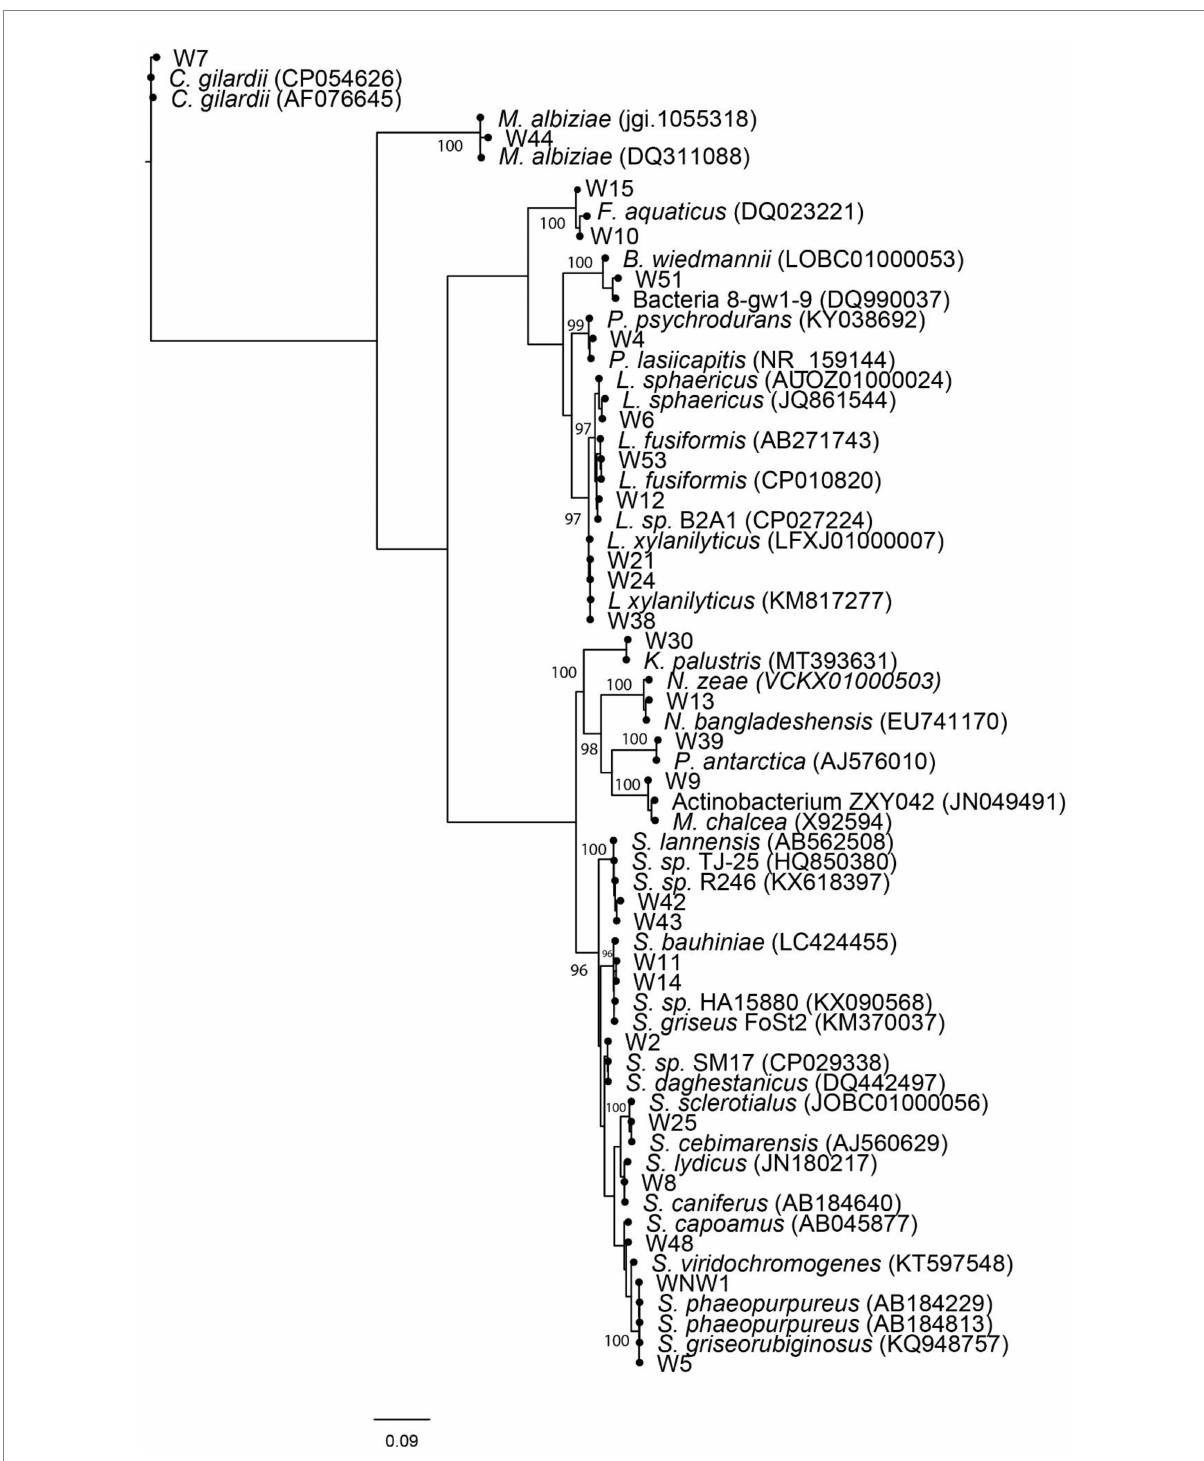
FIGURE 4 Weighted maximum likelihood tree, arbitrarily rooted on the branch leading to Proteobacteria. Non-parametric bootstrap values >95% have been indicated. Culture (NW1, W2–W54) isolates together with EzBioCloud and SILVA V1.38 database matches have been shown. Relative branch lengths are indicated, and scale length is indicated in substitutions per